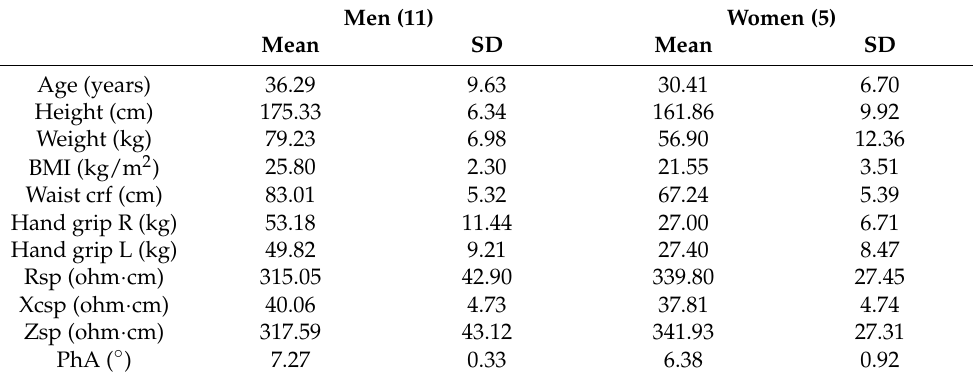
Table 1. Descriptive statistics of anthropometrical and bioelectrical variables.